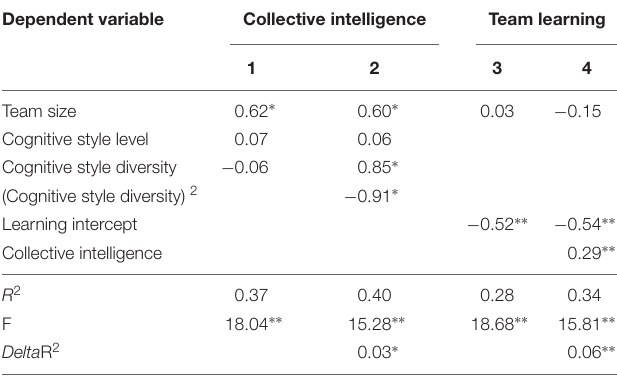
TABLE 2 | Results testing hypotheses 1 and 2 using OLS